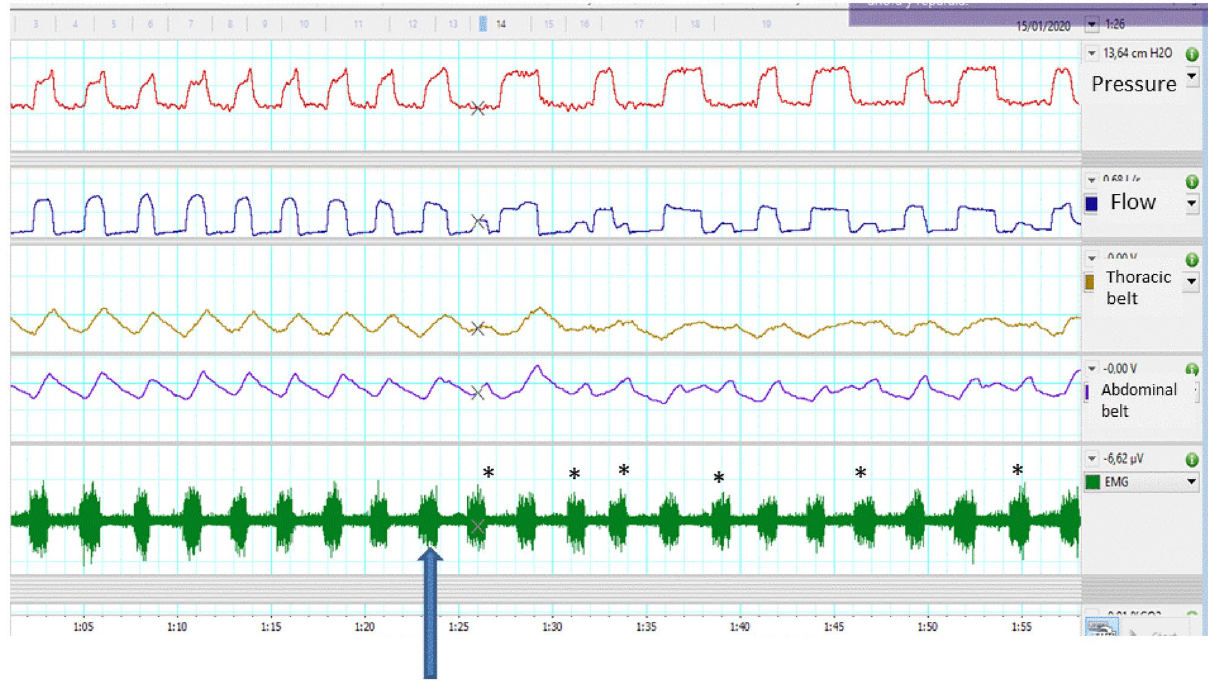
Figure 3. Example of a fully monitored patient. After the gas introduction (arrow), ineffective efforts (asterisks) can be easily detected. Observe the unassisted efforts in the belts and EMG